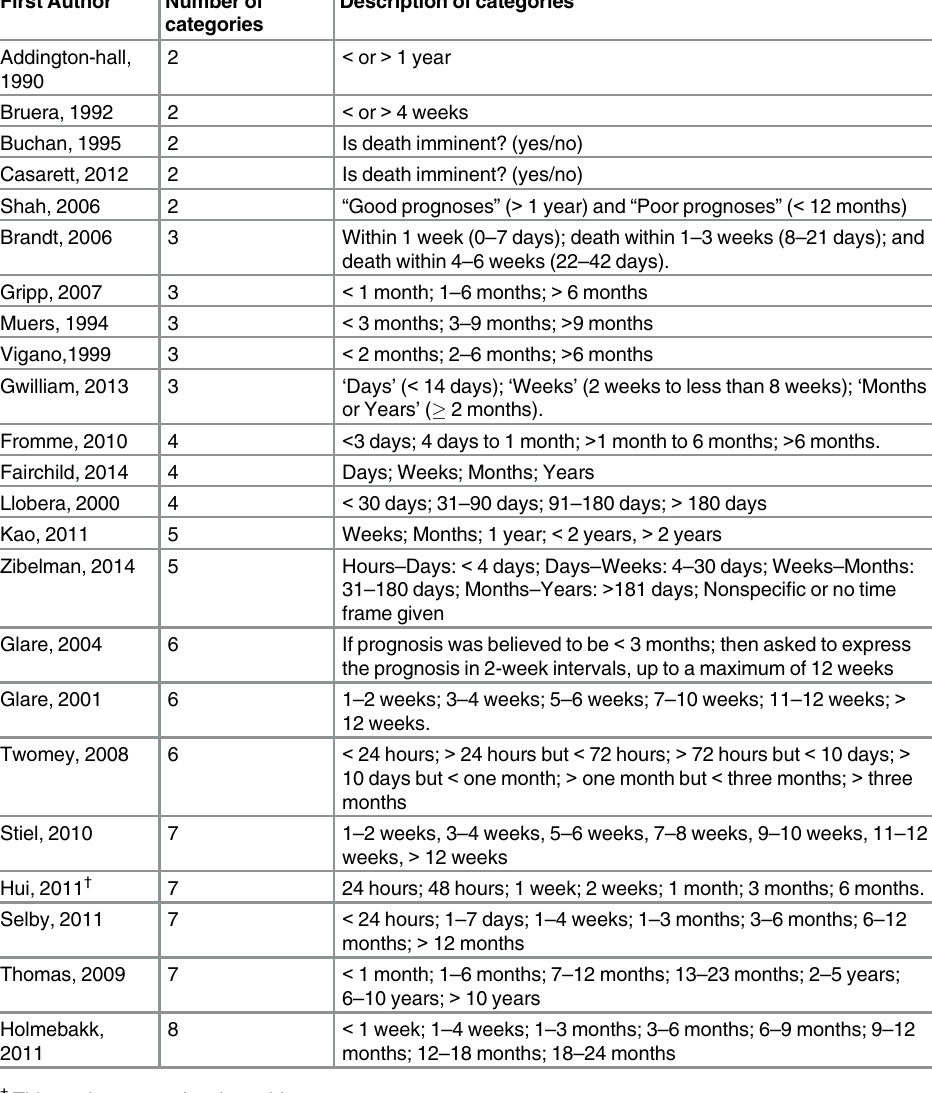
Table 2. Summary of studies in which clinicians were asked to predict survival using defined catego- ries (categorical